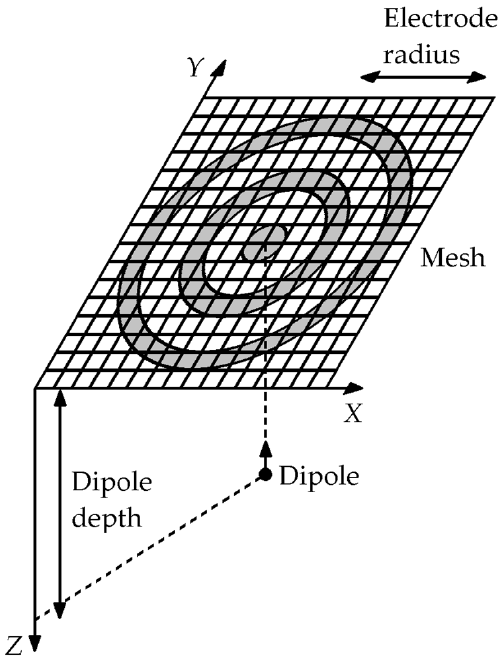
Figure 3. Schematic of the finite element method model used to compare the Laplacian estimates.